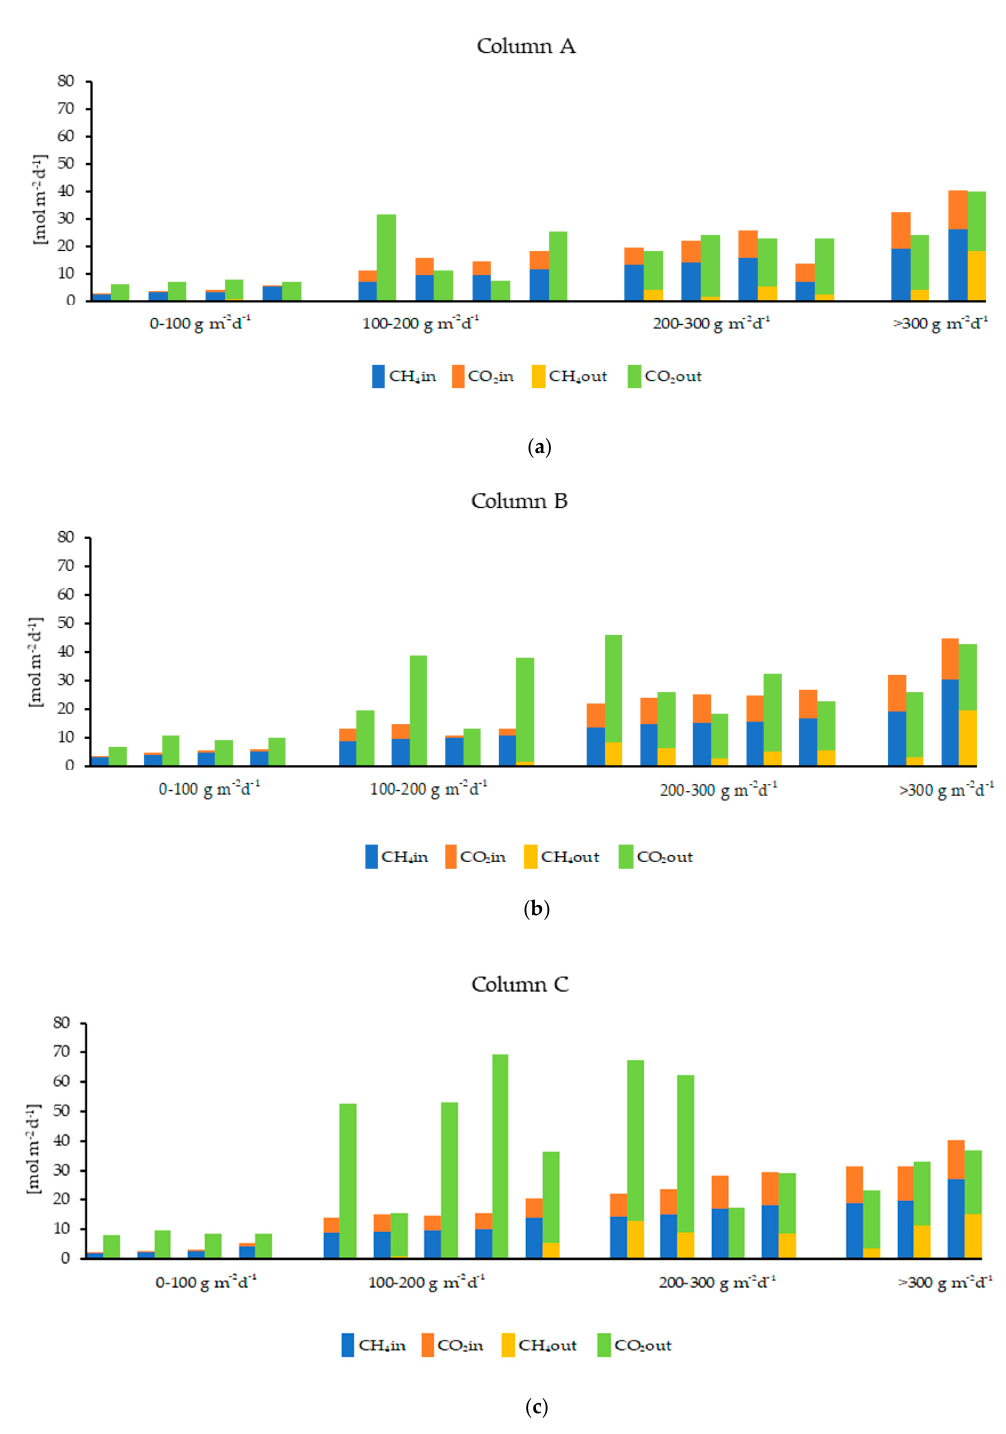
Figure 5. Mass balance between load and outflow of CH 4 and CO 2 : ( a ) Column A; ( b ) Column B; ( c ) Column C.